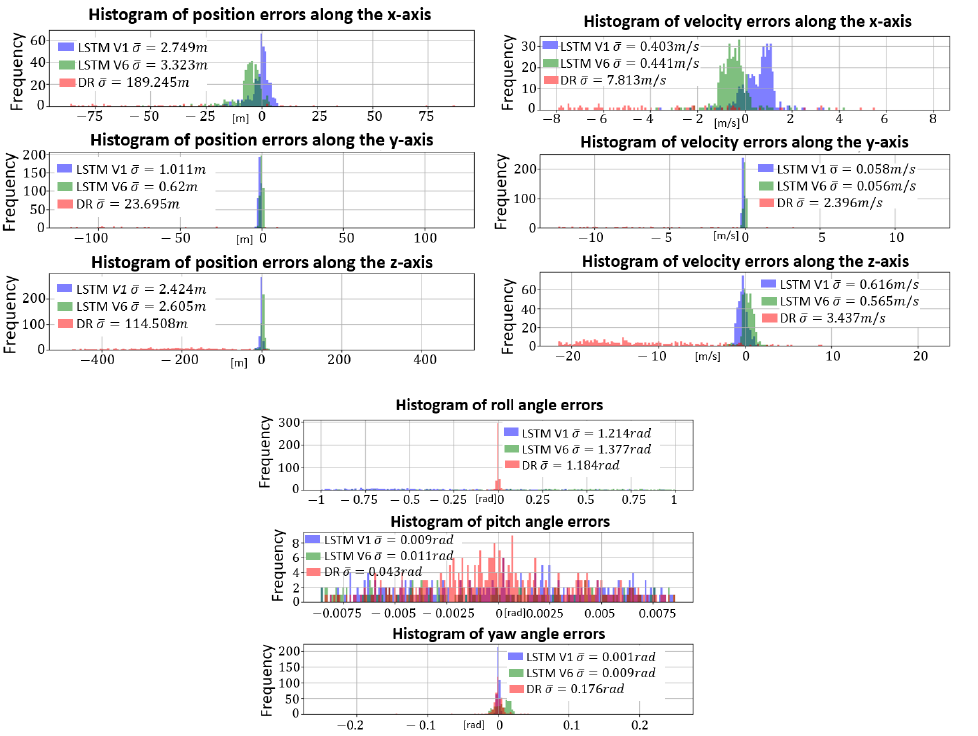
Figure 9. Average position, velocity and orientation error histogram obtained by LSTM IMU , V LSTM IMU , V (green) and Dead-Reckoning (red). 6